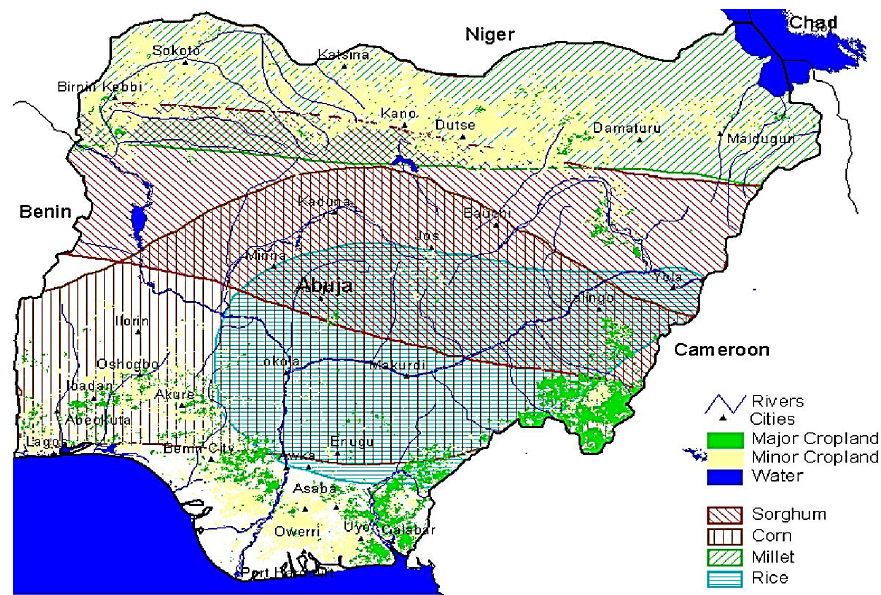
Fig. 2. Major crop zones in Nigeria